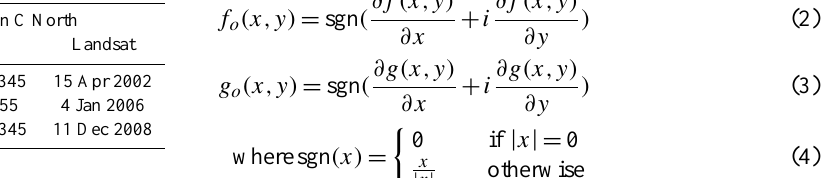
Table 1. MODIS and Landsat satellite images used for the velocity measurements. Larsen C South indicates Landsat images from path 216 row 108 and Larsen C North indicates Landsat images from path 216 row 107. Larsen C South Larsen C North MODIS Landsat MODIS